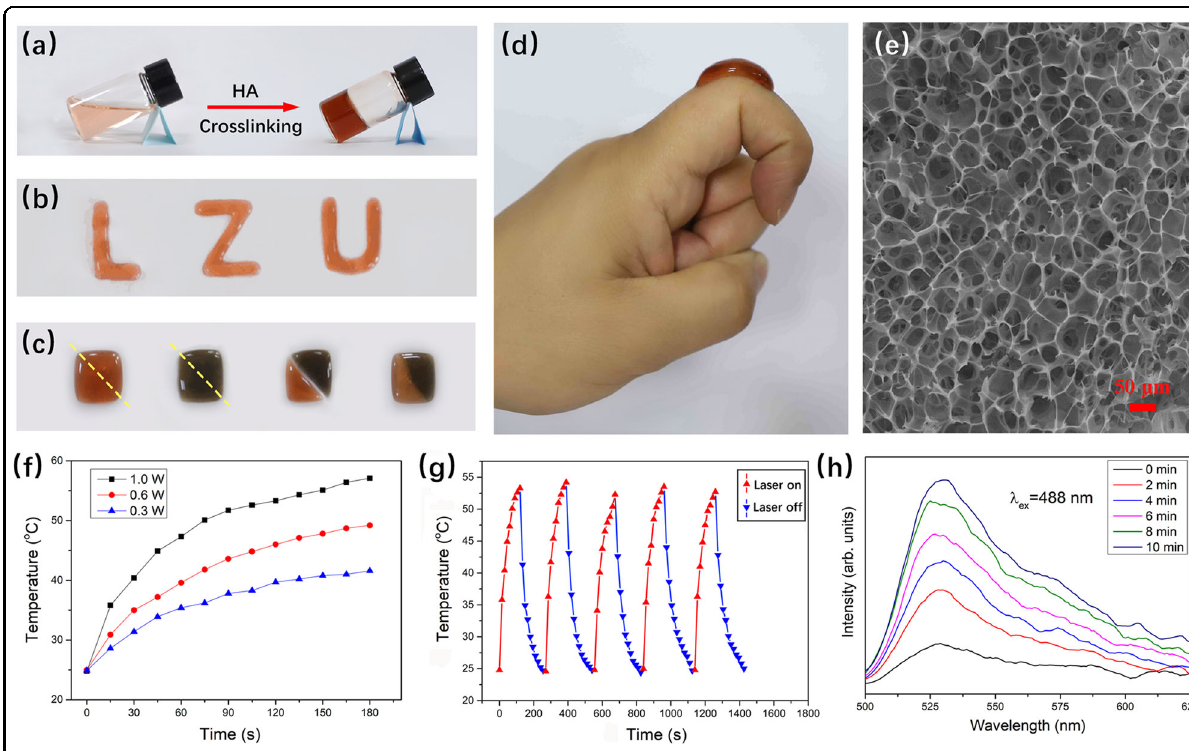
Fig. 2 Fabrication, morphology, and properties of PDA-HA hydrogel. a Gelation process, ( b ) reformability, ( c ) self-healing, ( d ) bioadhesion, and ( e ) SEM image of the PDA-HA hydrogel. f Photothermal-heating curves of the PDA-HA hydrogel under 808 nm laser irradiation (0.3, 0.5 or 1.0 W cm − 2 ) for 3 min. g Heating curves of the PDA-HA hydrogel for 5 on-off cycles under 808 nm laser irradiation (1.0 W cm − 2 ). h PL emission spectra of the PDA-HA hydrogel in PBS solution with λ ex = 488